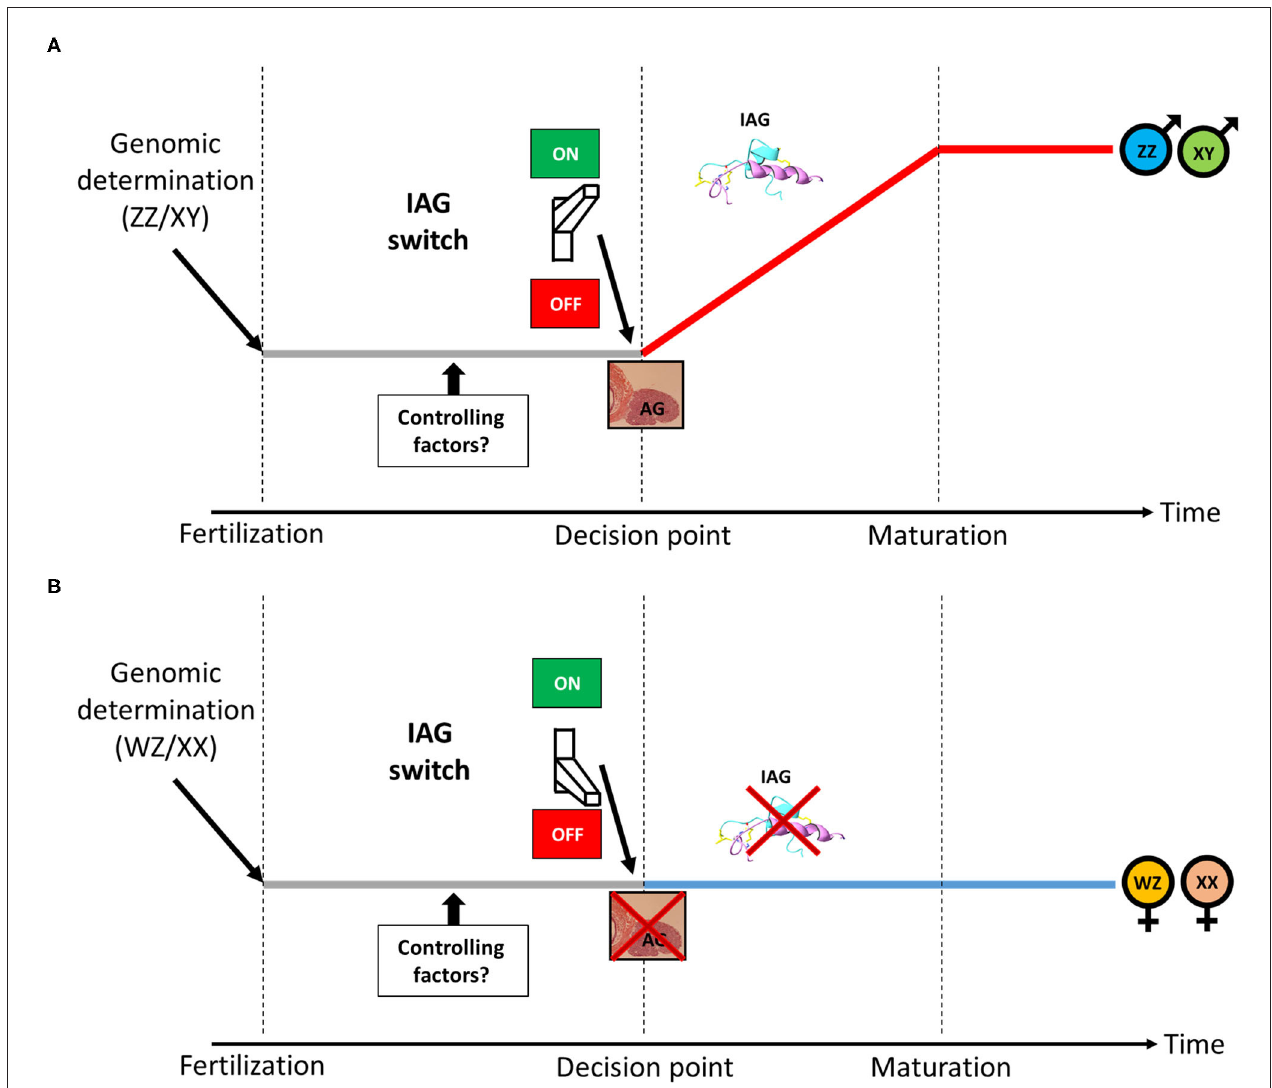
FIGURE 1 | The IAG-switch in gonochoristic crustaceans. (A) Following male genotypic determination (ZZ/XY), the IAG-switch initiates the formation of the IAG-secreting AG, leading to the development of a mature male. (B) Following female genotypic determination (WZ/XX), the IAG-switch inhibits the formation of the IAG-secreting AG, leading to the development of a mature female. The period in which putative upstream IAG-switch controlling factors are expressed is